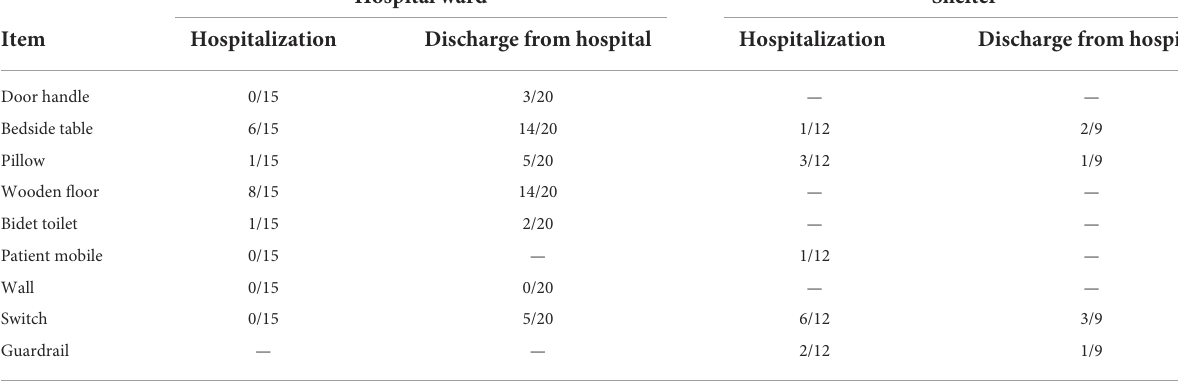
TABLE 1 Results of different environmental samples from 56 COVID-19 patients.